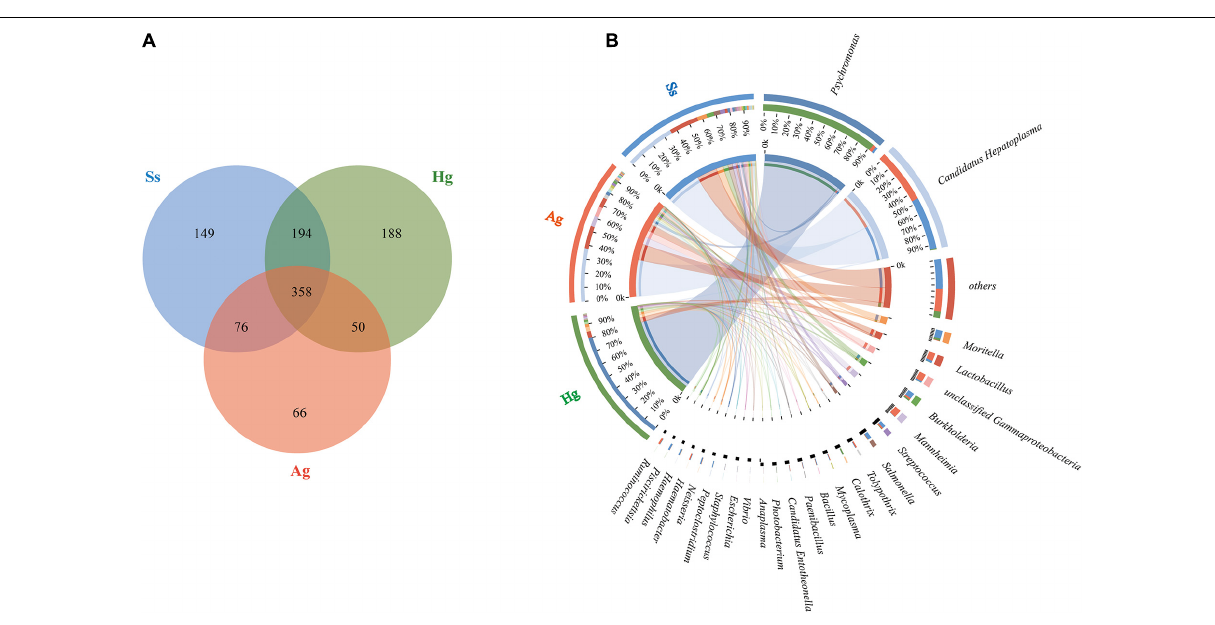
FIGURE 3 | Microbial diversity in three hadal amphipod groups. (A) Venn diagram illustrating total, unique, and shared numbers of genera predicted from three datasets. (B) Circos diagram illustrating genus-level microbial composition in all